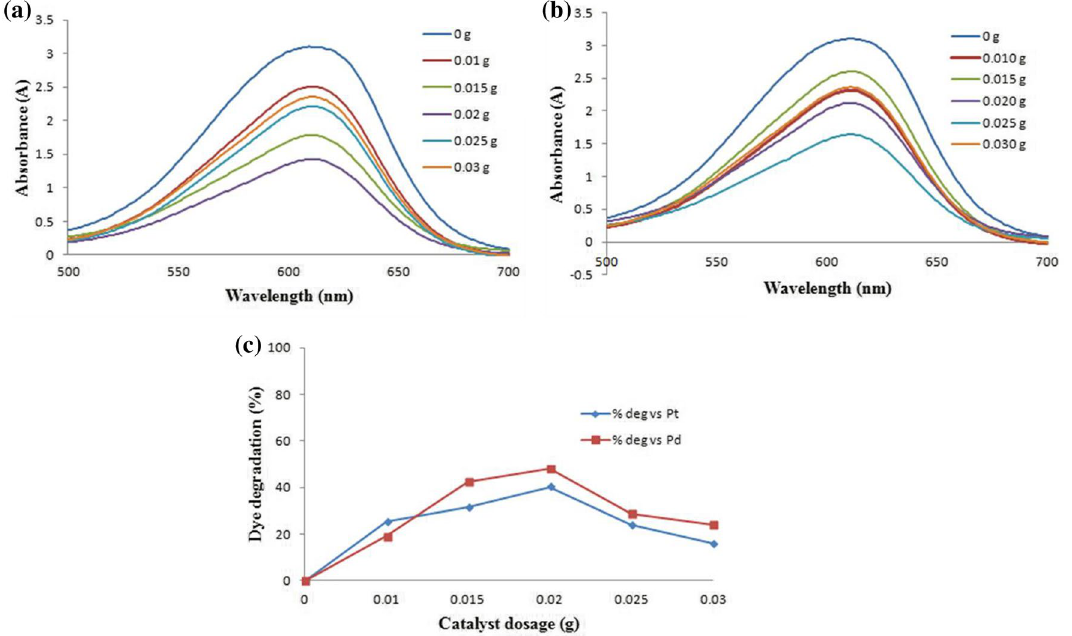
Fig. 4 a UV–VIS absorbance spectra of indigo disulfonate degraded at different catalyst dosages of Pd/ZrO degradation by different catalyst